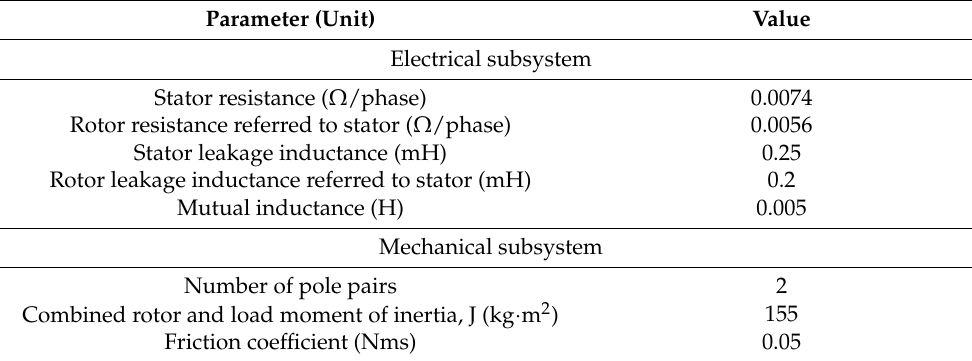
Table 5. Parameters of the induction